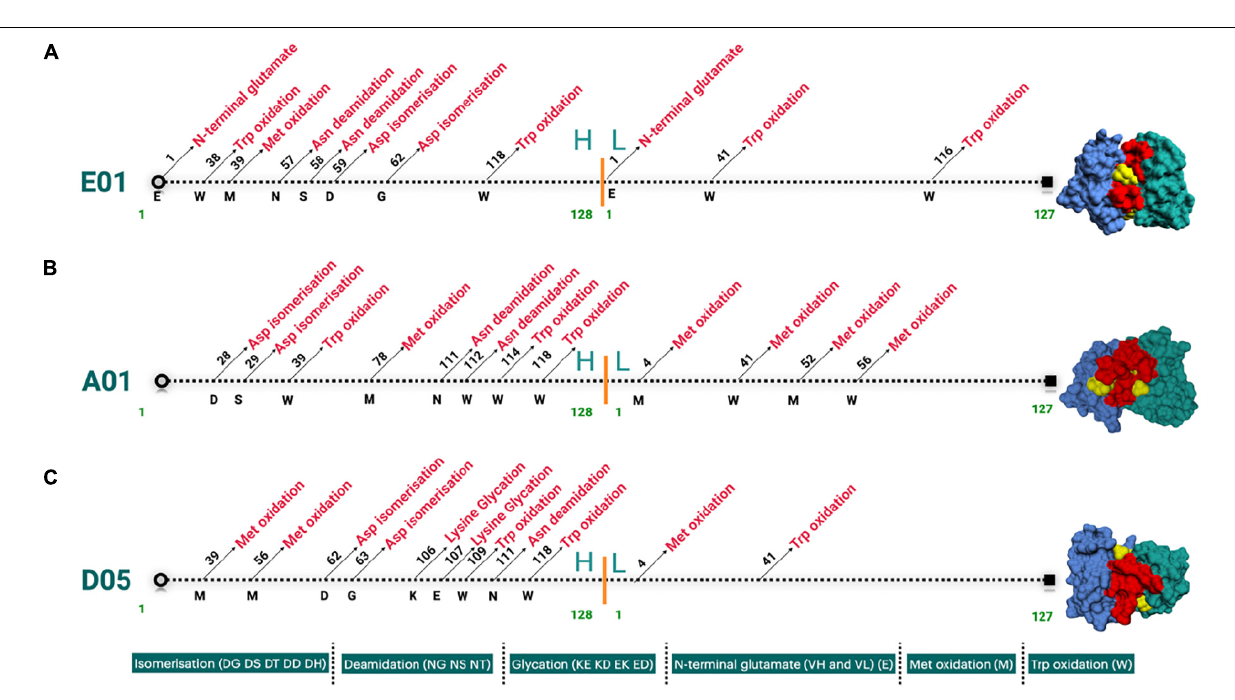
Frontiers in Cardiovascular Medicine |